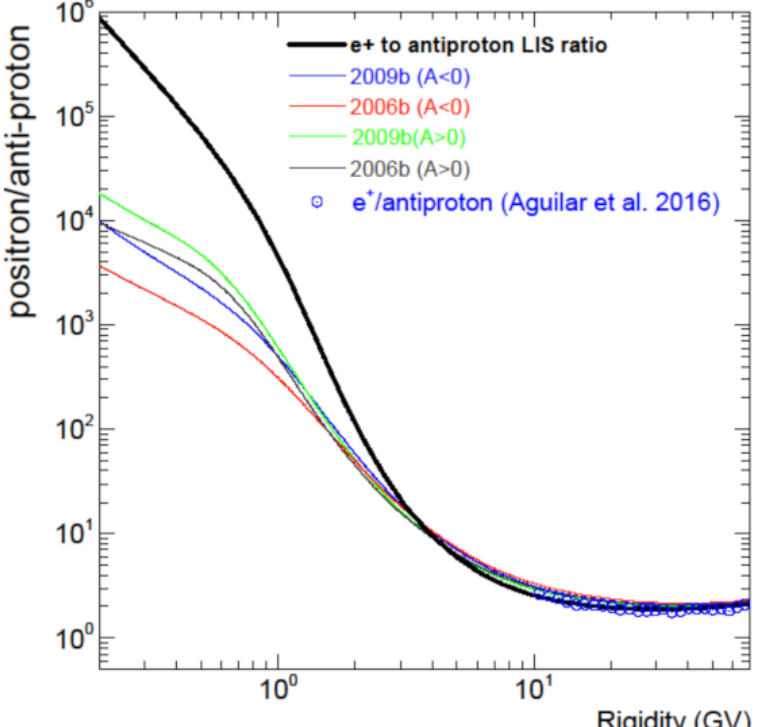
Figure 22. Ratio of the VLISs of positrons ( e + ) and anti-protons (solid black line) as a function of rigidity together with the corresponding simulated positron to anti-proton ratio at the Earth for modulation conditions in 2006b (red lines) and 2009b (blue lines) and for both drift cycles A < 0 and A > 0. The latter, indicated as green and grey lines, serve as predictions for the present solar minimum epoch. Observational ratio (blue circles) above 10 GV is from